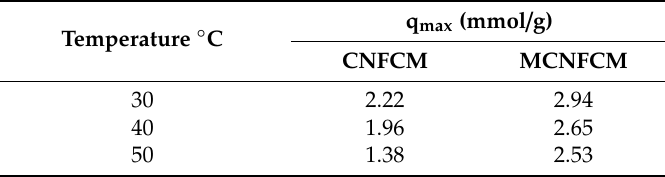
Table 10. CO 2 adsorption over di ff erent temperatures.